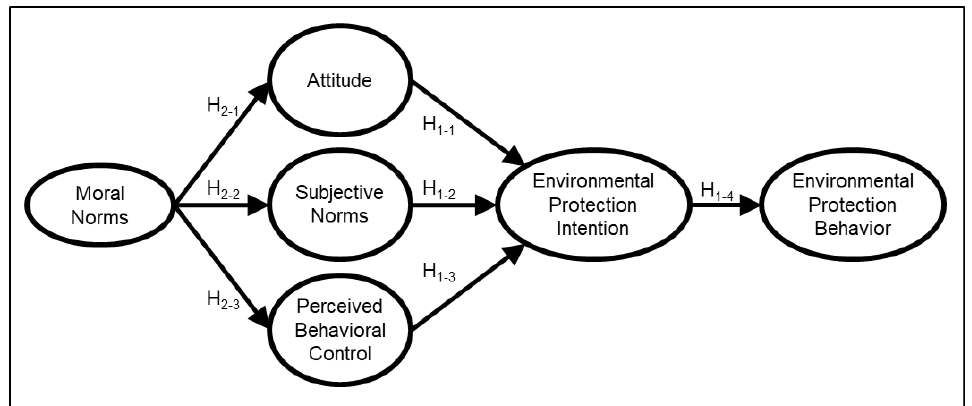
Figure 1. Theory of Planned Behavior and moral norms (Model ETPB) applied to environmental protection behaviors for undergraduates.